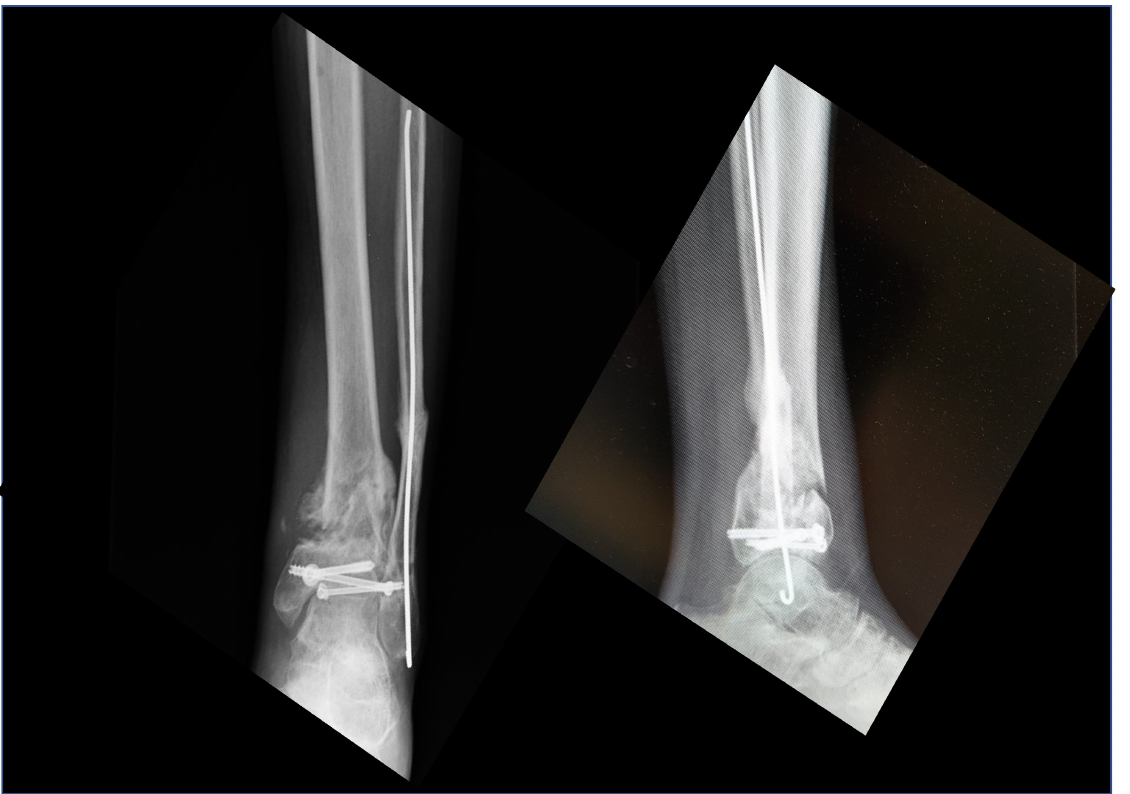
Figure 1. Pre-operative X-rays showing a case of septic non-union of the tibial pilon.